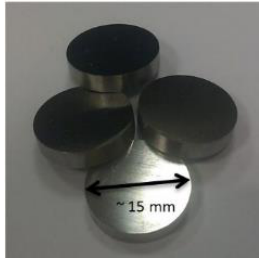
Figure 3. The geometry of the samples for the corrosion test.